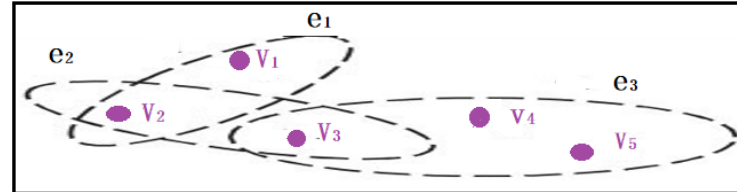
Figure 6. Hypergraph structure.